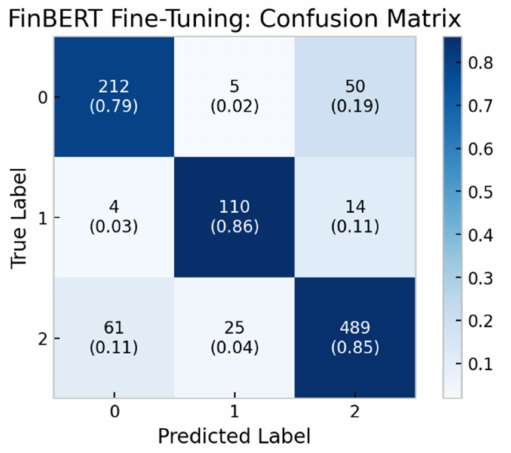
Figure 7. Confusion matrix for FinBERT sentiment